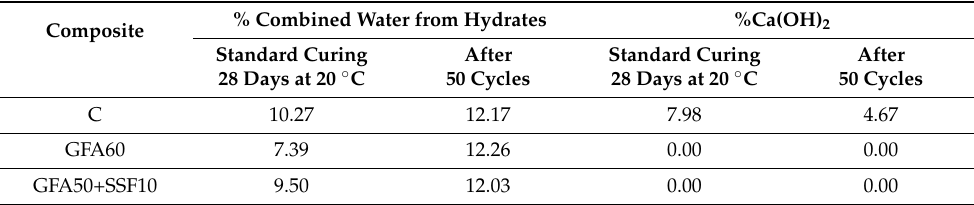
Table 6. Thermogravimetry results on the composites subjected to wetting–drying tests with 3.5% NaCl